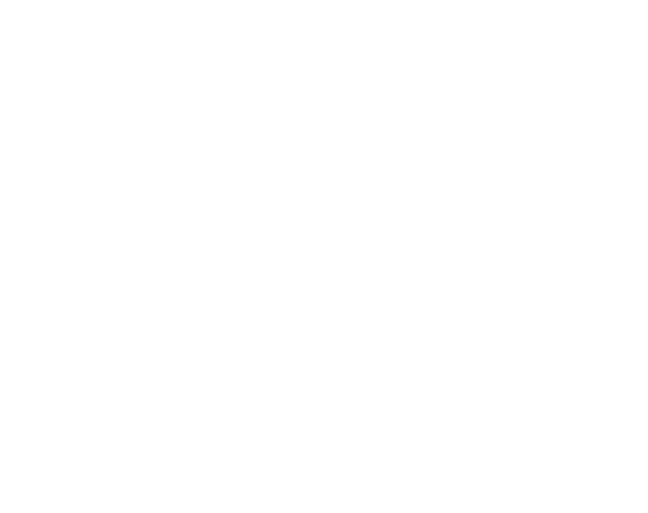
Figure 13. Comparison between the experimental results and the calculated results under different deformation conditions: ( a ) 350 ◦ C; ( b ) 400 ◦ C; ( c ) 450 ◦ C.